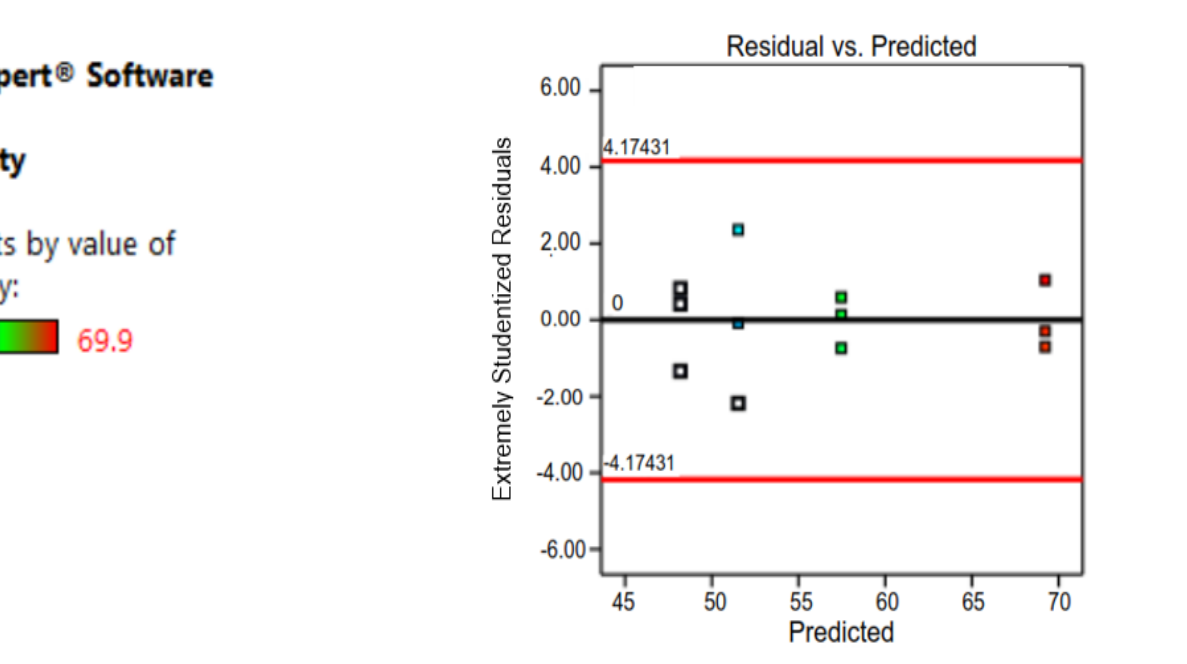
Figure 1. Data analysis for the normal plot of residuals.